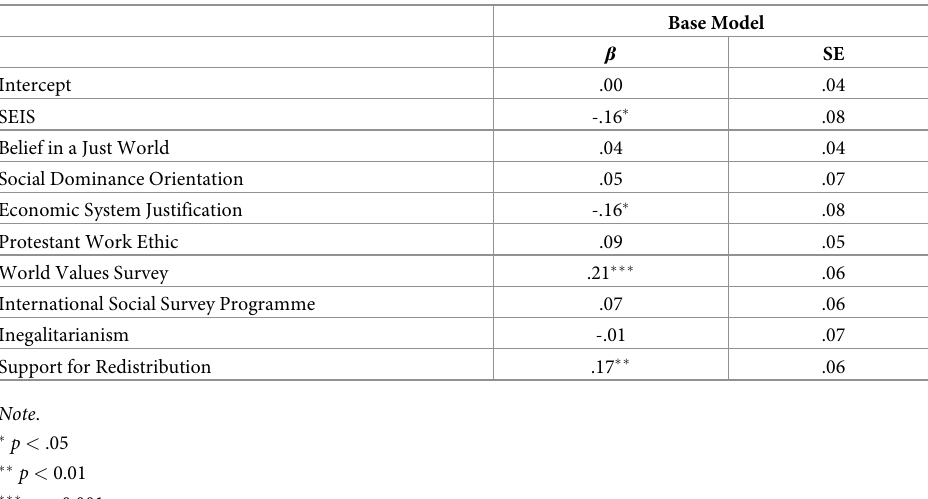
Table 7. Single regression model containing all predictors in Study 5 on raffle ticket